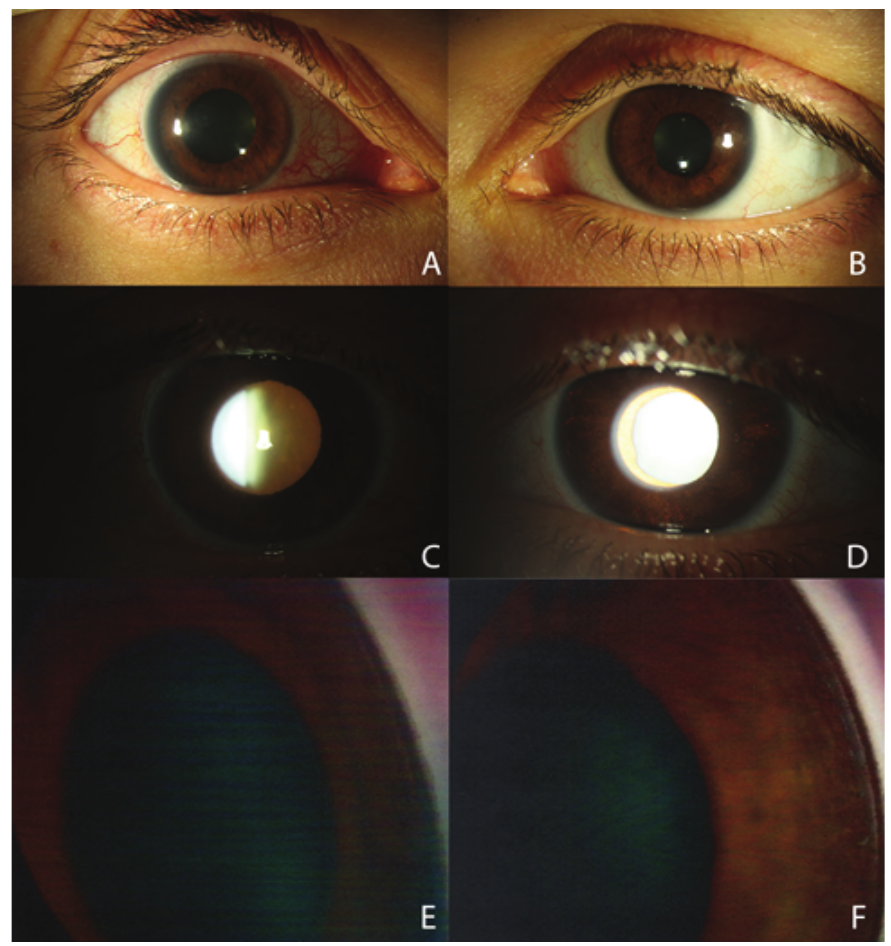
Figure 1. (A & B) External photos of the right and left eyes. The right eye has a mydriatic pupil with pupillary sphincter paralysis and nasal conjunctival injection. (C & D) Retroillumination photos of the right and left eyes. The right eye has a reduced red reflex, likely due to a more significant cataract. Visible in the left eye are diffuse, moth-eaten transillumination defects. (E & F) Gonioscopy photos of the right and left eyes showing open angles with dense trabecular meshwork